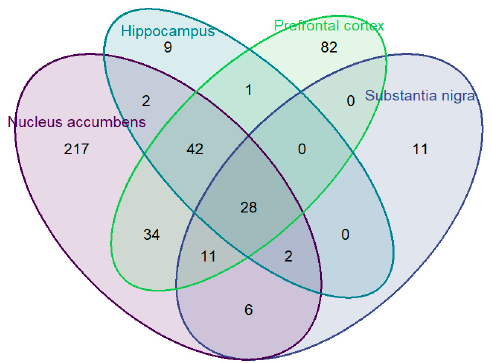
Figure 1. Venn diagram of cis- expression Quantitative Trait Loci (eQTL) of the selected seven genes in the dopamine pathway across four brain tissues.